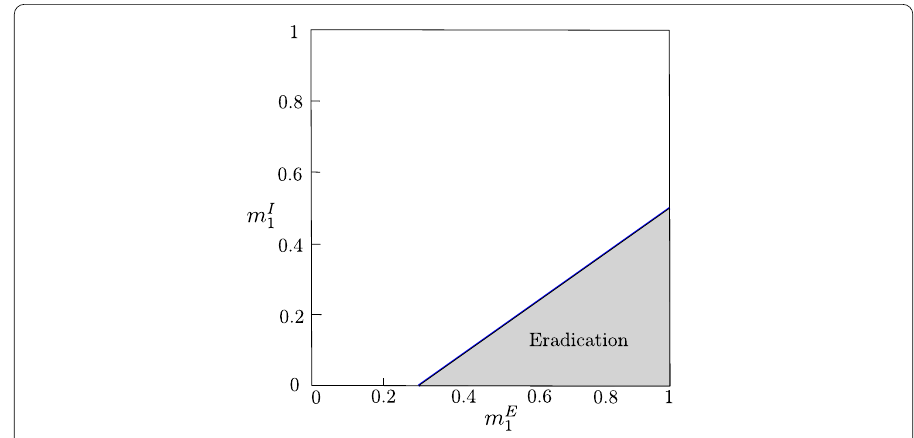
Figure 3 Let us consider system (15) with n = 2 and the following local parameter values: σ E and β j = 0.75, j ∈ { 1,2 } , so A = 0.5; σ I 1 = 0.75, σ I 2 = 0.87, γ I 1 = 0.11, and γ I 2 = 0.33. The shaded triangle contains the values of m E 1 and m I 1 , stable equilibrium proportions of exposed and infectious individuals in patch 1, that ensure R 0 < 1 in system (21) and, therefore, the disease eradication in system (15). The blue line corresponds to R 0 = 1